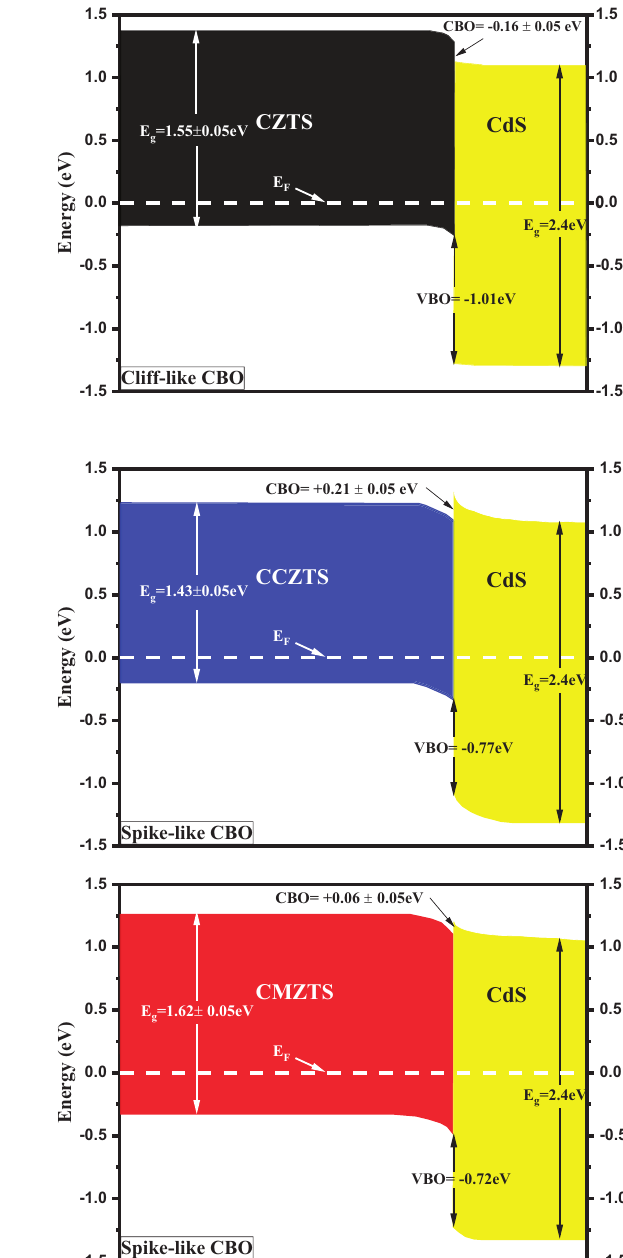
Fig. 9. Experimental band alignment at absorber/buffer hetero- junction. (a) CZTS/CdS, (b) CCZTS/CdS, (c)